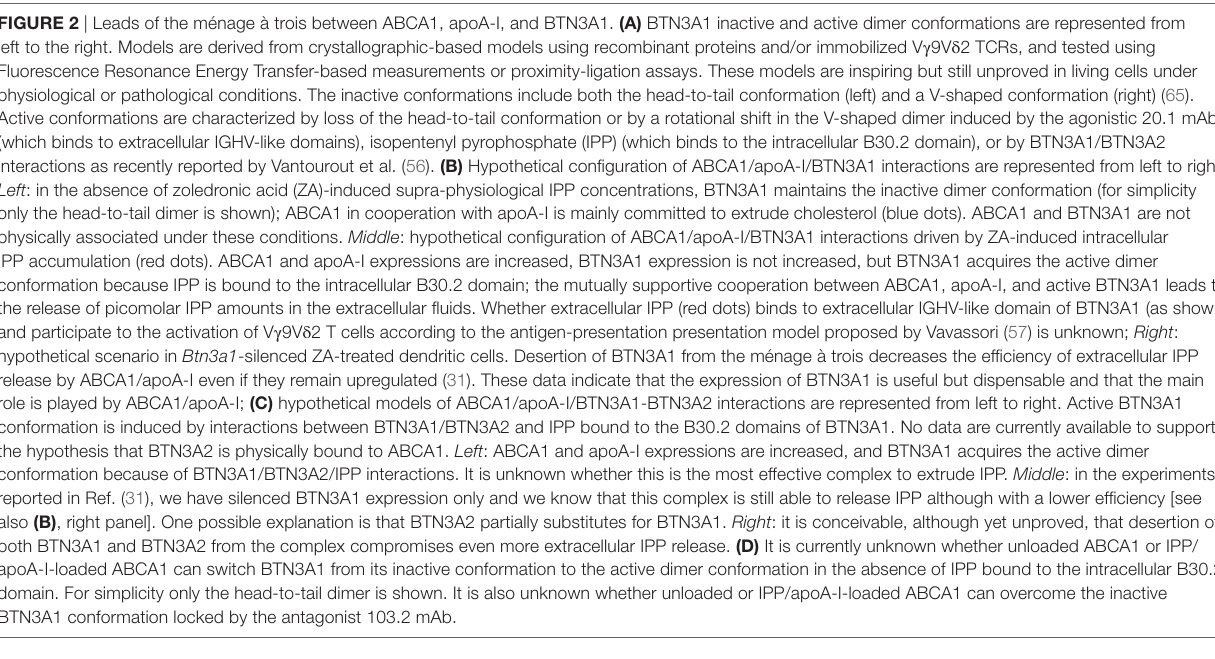
FiGURe 2 | Leads of the ménage à trois between ABCA1, apoA-I, and BTN3A1. (A) BTN3A1 inactive and active dimer conformations are represented from left to the right. Models are derived from crystallographic-based models using recombinant proteins and/or immobilized V γ 9V δ 2 TCRs, and tested using Fluorescence Resonance Energy Transfer-based measurements or proximity-ligation assays. These models are inspiring but still unproved in living cells under physiological or pathological conditions. The inactive conformations include both the head-to-tail conformation (left) and a V-shaped conformation (right) (65). Active conformations are characterized by loss of the head-to-tail conformation or by a rotational shift in the V-shaped dimer induced by the agonistic 20.1 mAb (which binds to extracellular IGHV-like domains), isopentenyl pyrophosphate (IPP) (which binds to the intracellular B30.2 domain), or by BTN3A1/BTN3A2 interactions as recently reported by Vantourout et al. (56). (B) Hypothetical configuration of ABCA1/apoA-I/BTN3A1 interactions are represented from left to right. Left : in the absence of zoledronic acid (ZA)-induced supra-physiological IPP concentrations, BTN3A1 maintains the inactive dimer conformation (for simplicity only the head-to-tail dimer is shown); ABCA1 in cooperation with apoA-I is mainly committed to extrude cholesterol (blue dots). ABCA1 and BTN3A1 are not physically associated under these conditions. Middle : hypothetical configuration of ABCA1/apoA-I/BTN3A1 interactions driven by ZA-induced intracellular IPP accumulation (red dots). ABCA1 and apoA-I expressions are increased, BTN3A1 expression is not increased, but BTN3A1 acquires the active dimer conformation because IPP is bound to the intracellular B30.2 domain; the mutually supportive cooperation between ABCA1, apoA-I, and active BTN3A1 leads to the release of picomolar IPP amounts in the extracellular fluids. Whether extracellular IPP (red dots) binds to extracellular IGHV-like domain of BTN3A1 (as shown) and participate to the activation of V γ 9V δ 2 T cells according to the antigen-presentation presentation model proposed by Vavassori (57) is unknown; Right : hypothetical scenario in Btn3a1 -silenced ZA-treated dendritic cells. Desertion of BTN3A1 from the ménage à trois decreases the efficiency of extracellular IPP release by ABCA1/apoA-I even if they remain upregulated (31). These data indicate that the expression of BTN3A1 is useful but dispensable and that the main role is played by ABCA1/apoA-I; (C) hypothetical models of ABCA1/apoA-I/BTN3A1-BTN3A2 interactions are represented from left to right. Active BTN3A1 conformation is induced by interactions between BTN3A1/BTN3A2 and IPP bound to the B30.2 domains of BTN3A1. No data are currently available to support the hypothesis that BTN3A2 is physically bound to ABCA1. Left : ABCA1 and apoA-I expressions are increased, and BTN3A1 acquires the active dimer conformation because of BTN3A1/BTN3A2/IPP interactions. It is unknown whether this is the most effective complex to extrude IPP. Middle : in the experiments reported in Ref. (31), we have silenced BTN3A1 expression only and we know that this complex is still able to release IPP although with a lower efficiency [see also (B) , right panel]. One possible explanation is that BTN3A2 partially substitutes for BTN3A1. Right : it is conceivable, although yet unproved, that desertion of both BTN3A1 and BTN3A2 from the complex compromises even more extracellular IPP release. (D) It is currently unknown whether unloaded ABCA1 or IPP/ apoA-I-loaded ABCA1 can switch BTN3A1 from its inactive conformation to the active dimer conformation in the absence of IPP bound to the intracellular B30.2 domain. For simplicity only the head-to-tail dimer is shown. It is also unknown whether unloaded or IPP/apoA-I-loaded ABCA1 can overcome the inactive BTN3A1 conformation locked by the antagonist 103.2